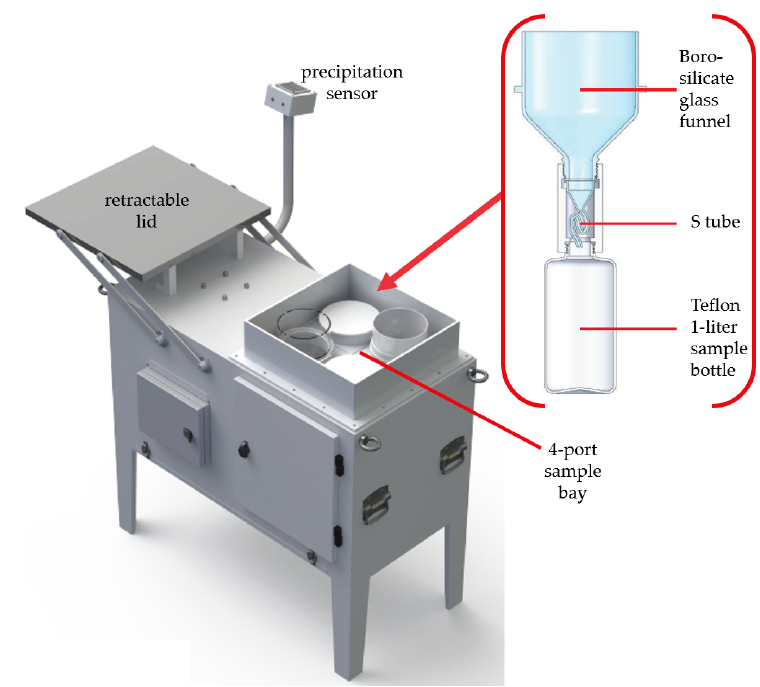
Figure 2. Asia Pacific Mercury Monitoring Network (APMMN) Wet Deposition Sampler, including the sample funnel and